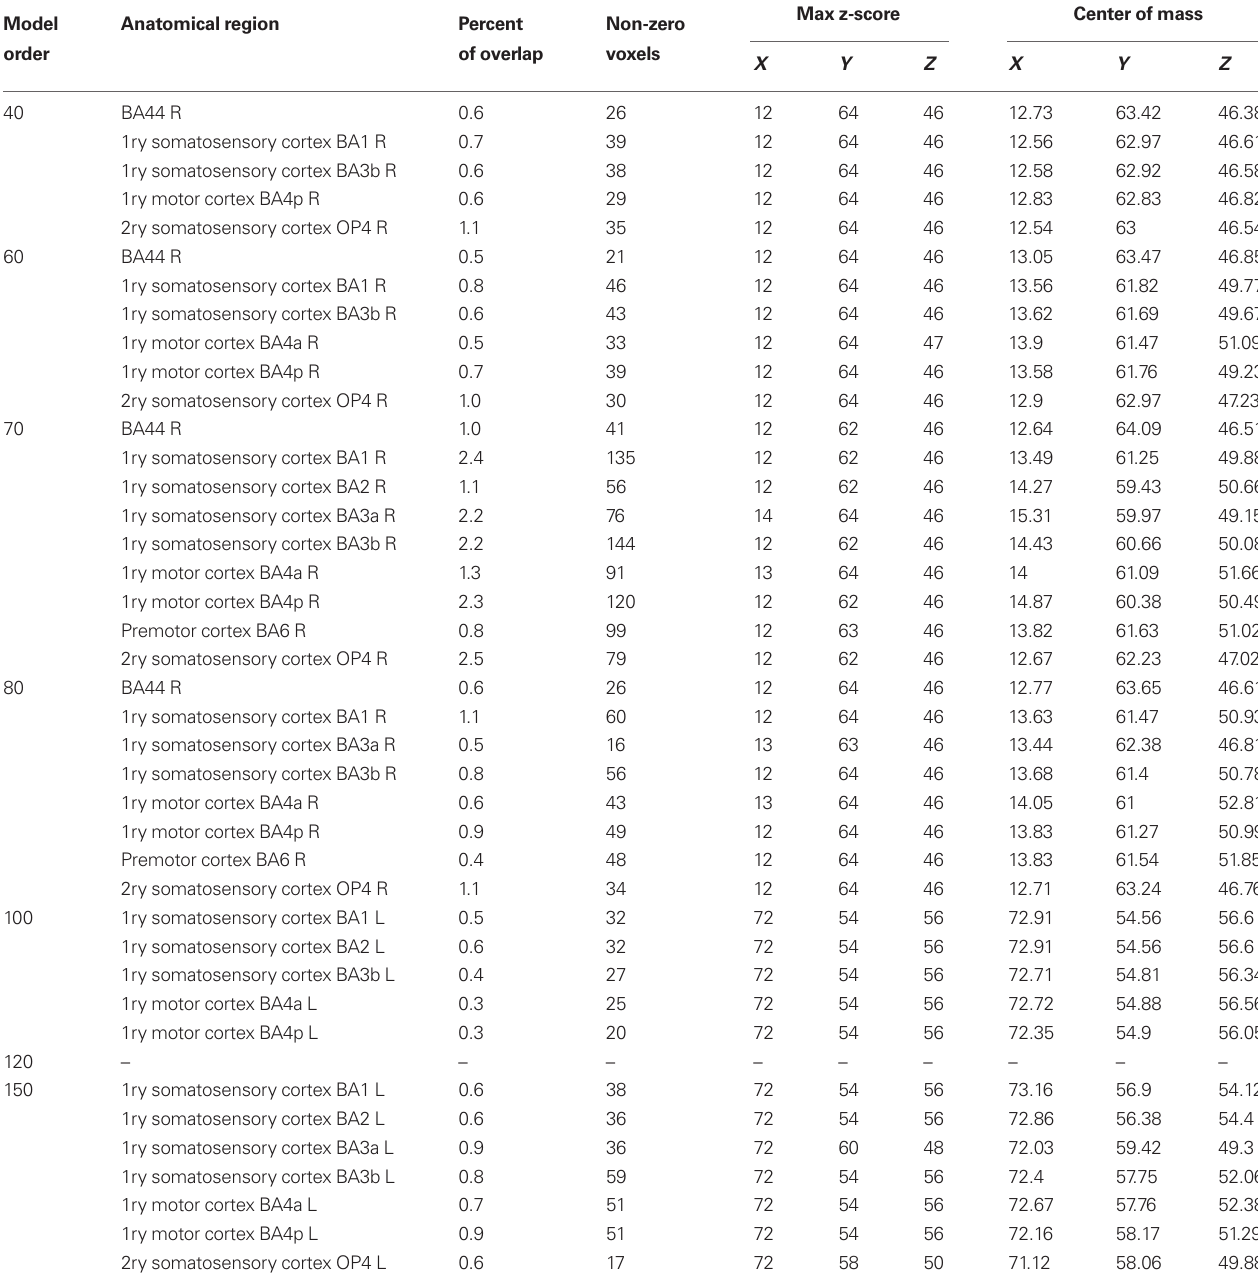
Table 7 | SAD functional connectivity differences in the motor cortex at all estimated ICA model